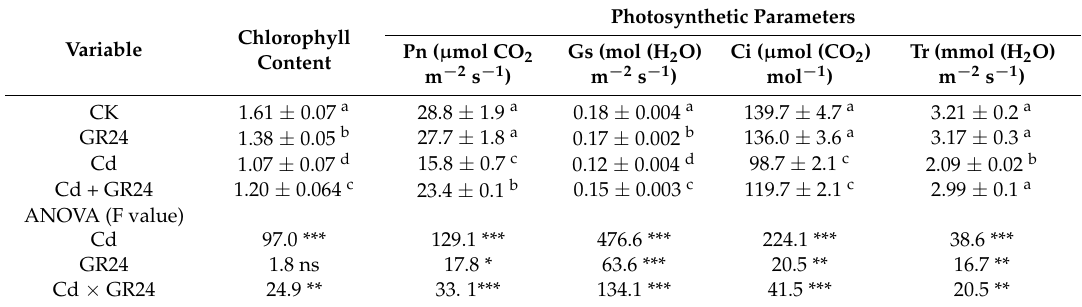
Table 2. Chlorophyll and photosynthetic gas exchange in switchgrass leaves treated with Cd and GR24